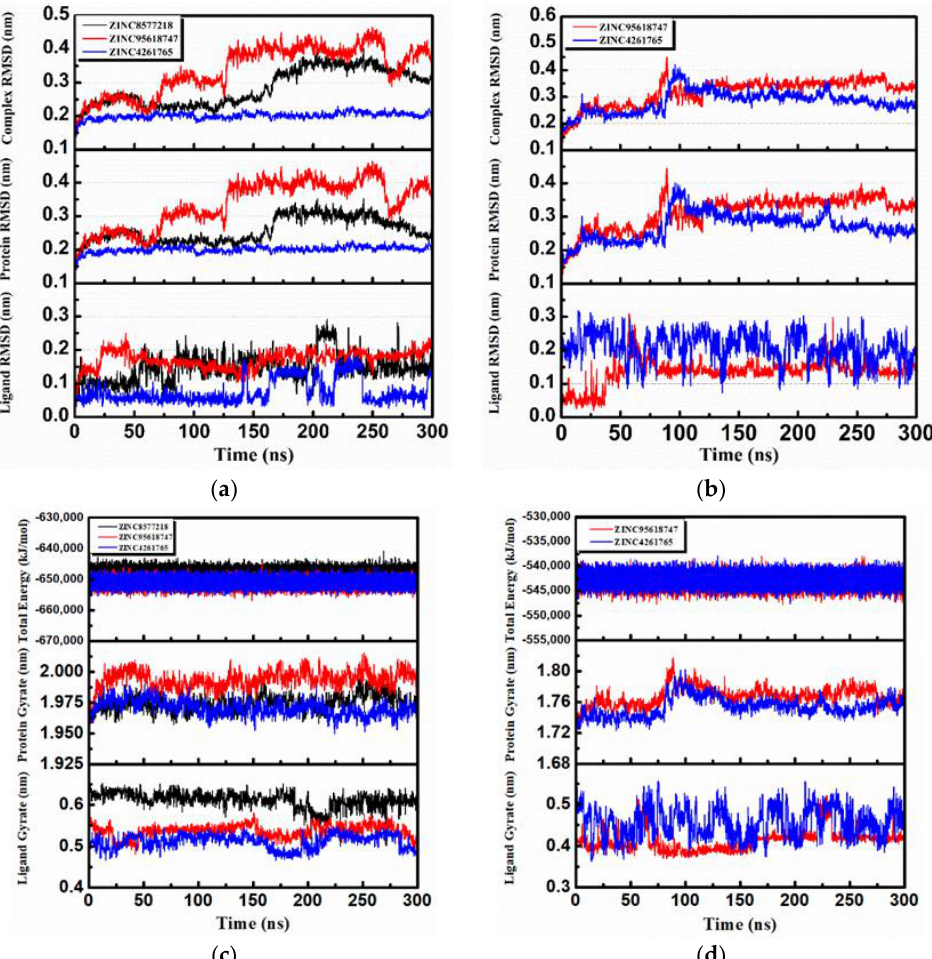
Figure 16. Root-mean-square deviation (RMSD), total energy, and gyrate analysis of each receptor– ligand complex in molecular dynamics simulation. ( a ) RMSD of the complex, protein, and ligand of DHODH complexes. ( b ) RMSD of the complex, protein, and ligand of UMPS complexes. ( c ) Total energy and gyrate of protein and ligand of DHODH complexes. ( d ) Total energy and gyrate of protein and ligand of UMPS complexes.